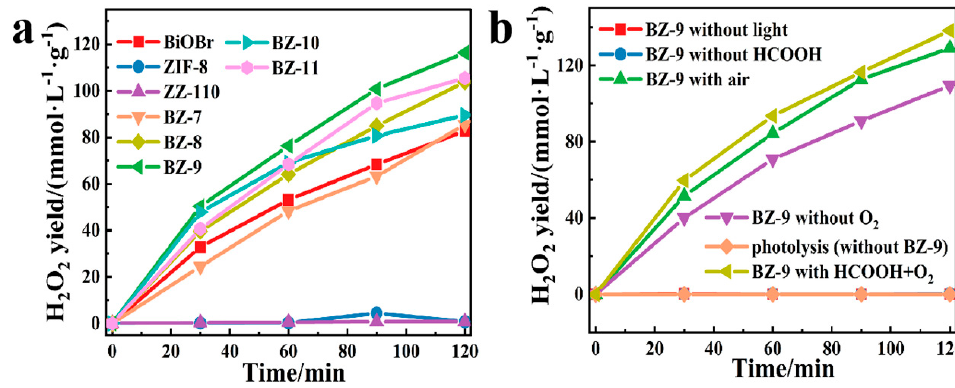
Figure 7. H 2 O 2 production capacity on prepared materials ( a ); H 2 O 2 production experiment of BZ-9 under different conditions ( b ).